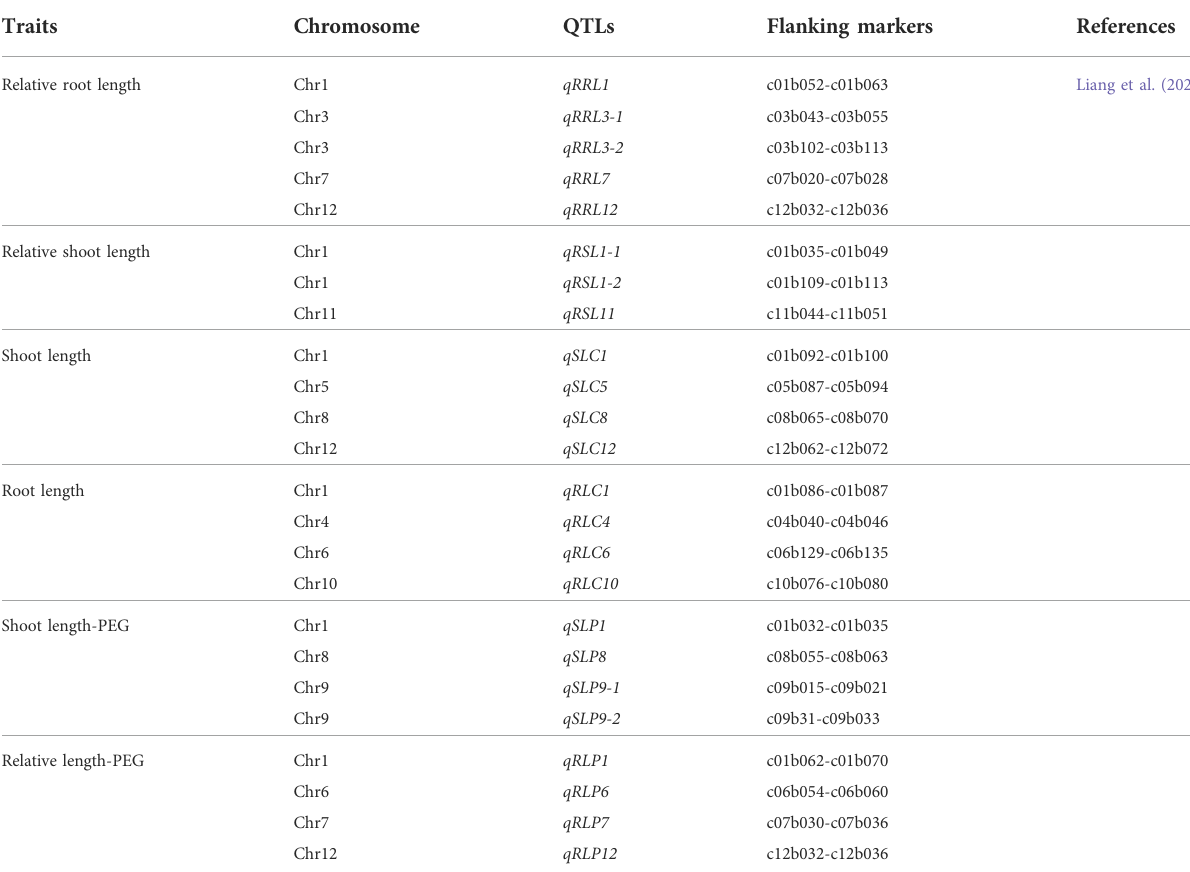
TABLE 4 Twenty-four shoot and root length QTLs associated with plant